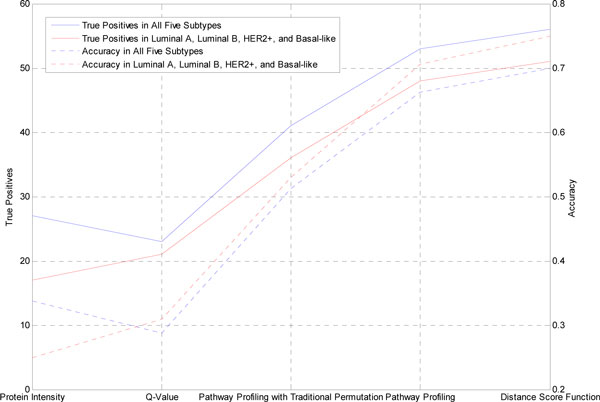
true positives and accuracy with four metrics and traditional permutation.